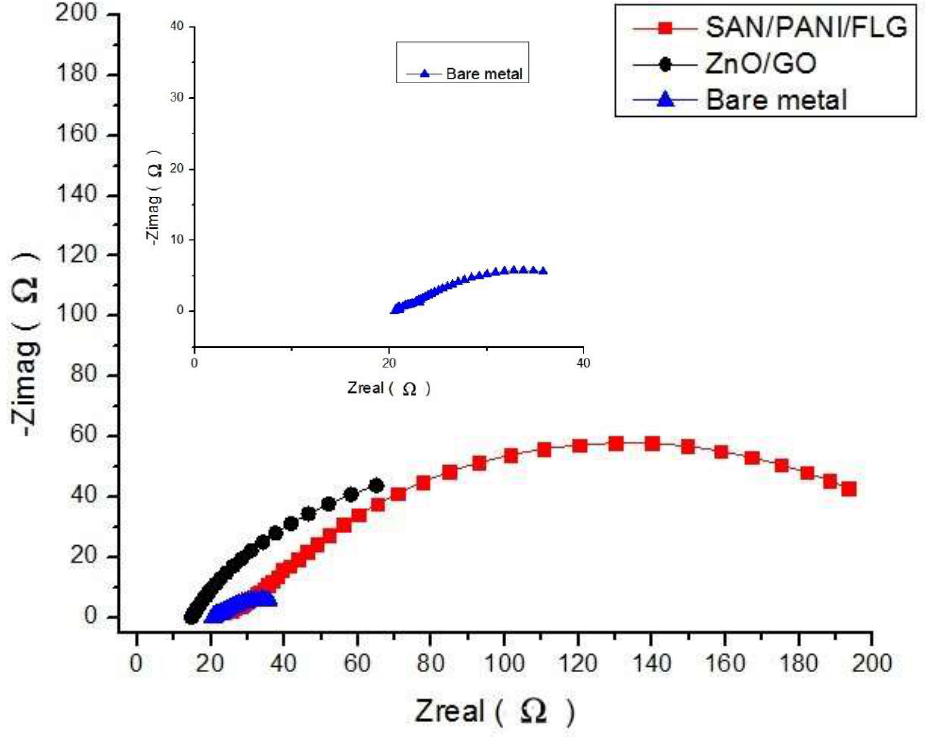
Figure 3. Nyquist Plots of bare and coated samples seawater.